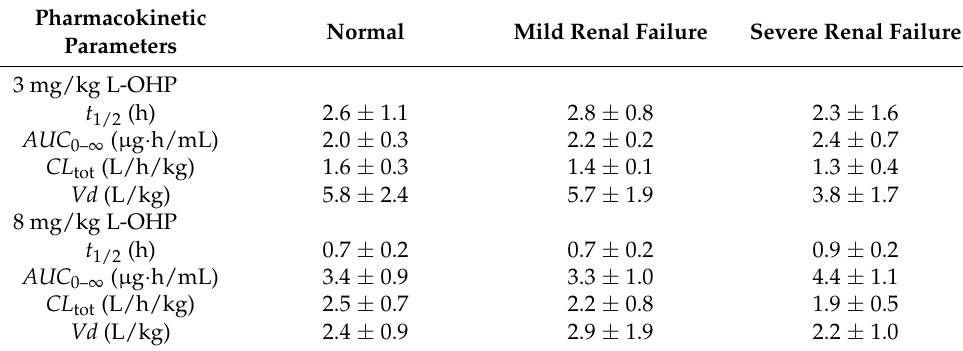
Each value represents the mean ± S.D. of four to five rats. t 1/2 , elimination half-life; AUC 0– ∞ , area under the plasma concentration–time curve from time of dosing to infinity; CL tot , total plasma clearance; Vd , distribution volume; MRT , mean residence time.